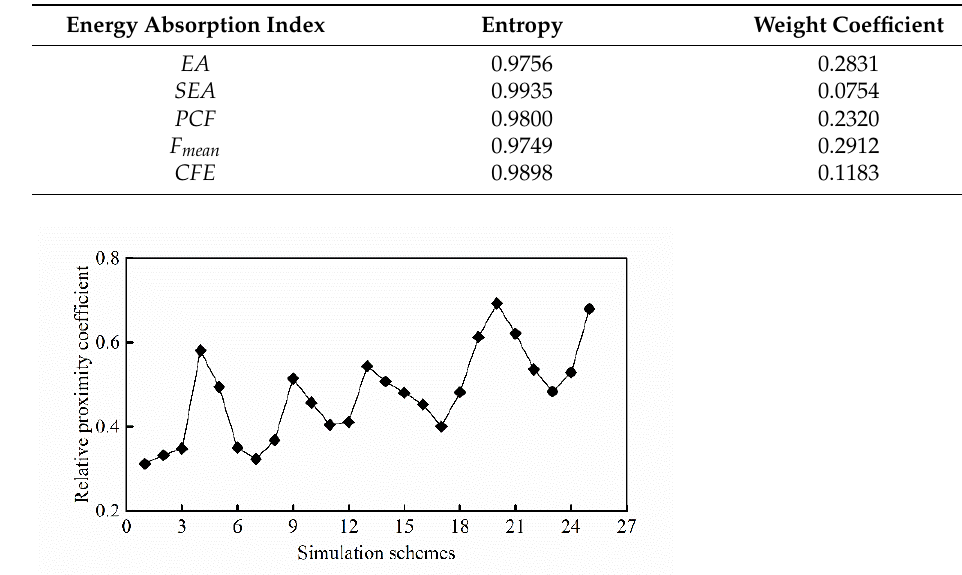
Table 9. Weight coefficients of energy absorption indexes.